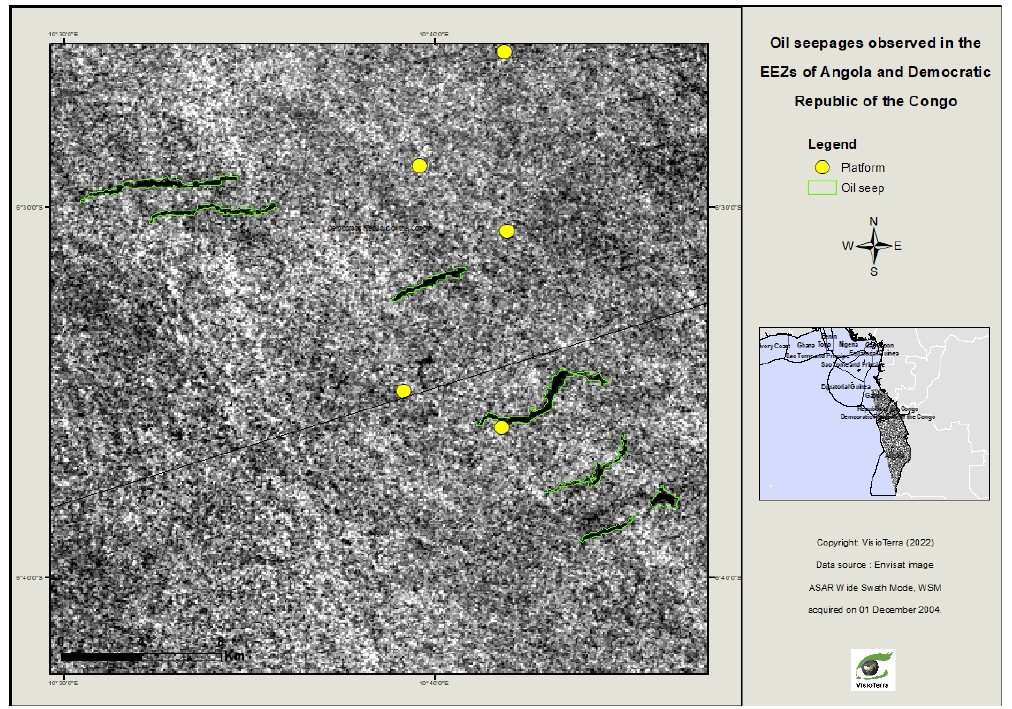
Figure 7. Oil seeps (1 December 2004) observed in the EEZs of Angola and the Democratic Republic of the Congo. The platforms are represented by the yellow dots.